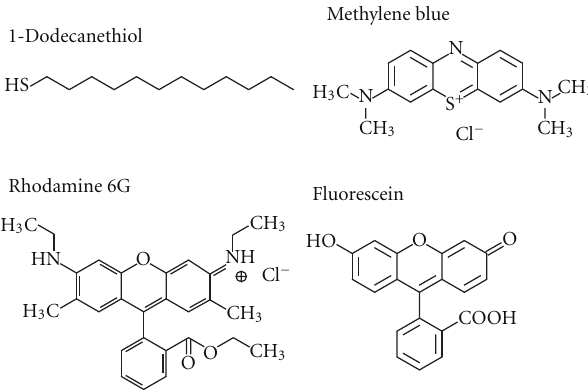
Figure 3: Skeletal models of the molecules used in SERS.